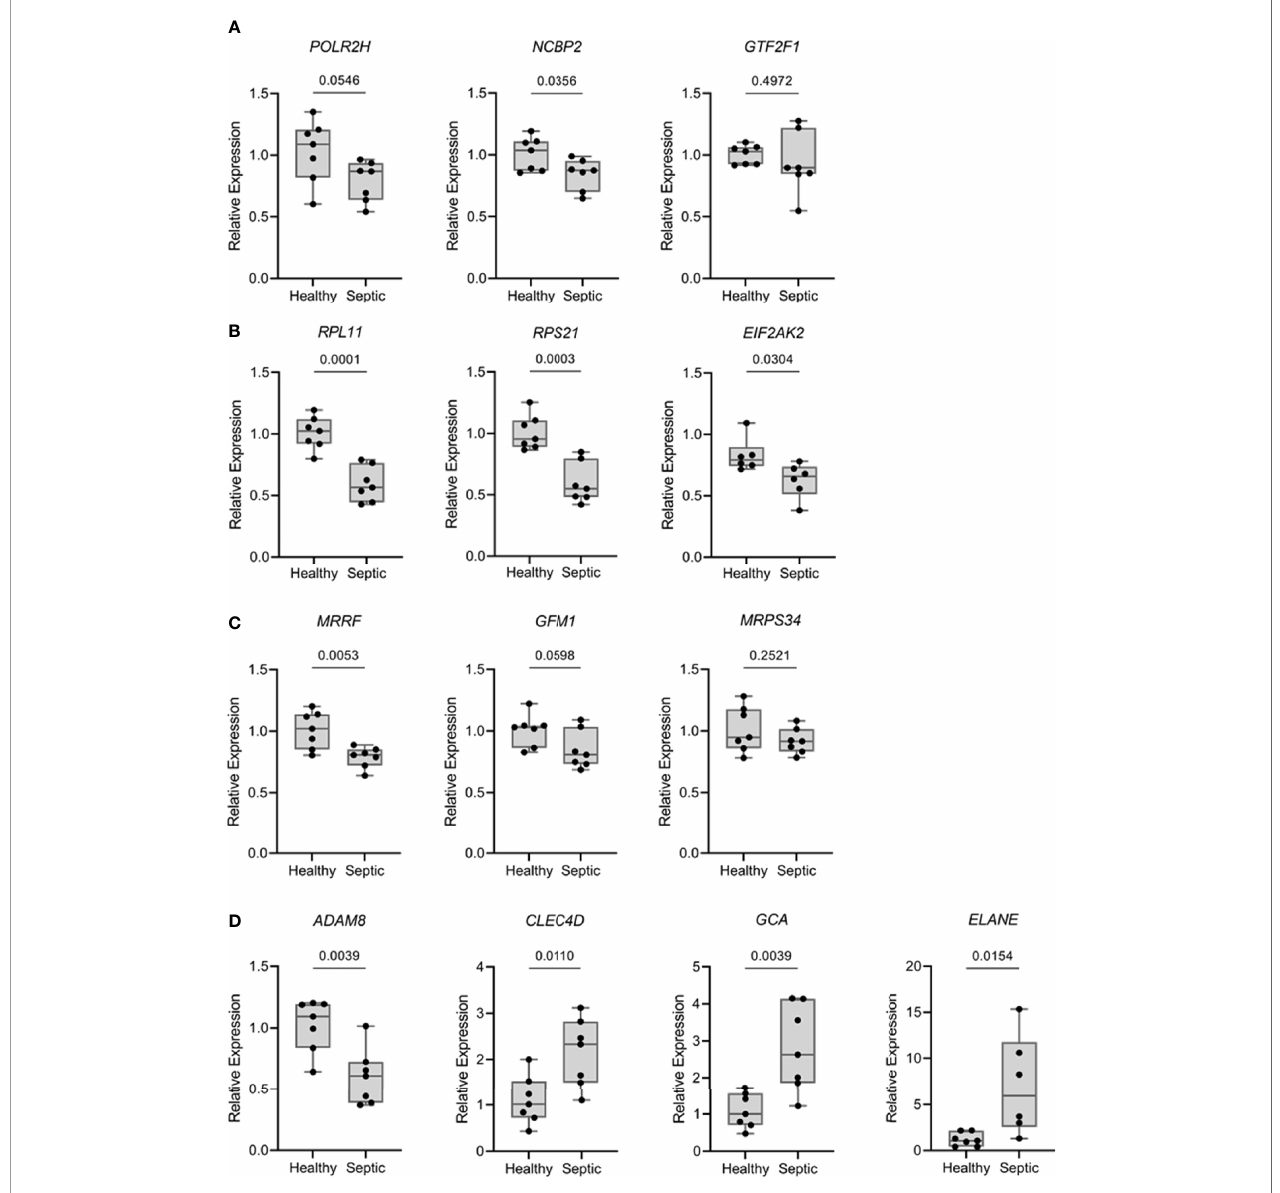
FIGURE 5 | Expression levels of relevant mRNA from over-represented pathways were analyzed by qPCR comparing septic patients ( n = 7) with healthy volunteers ( n = 7). Results are expressed as the relative gene expression (2 - ΔΔ Ct ). (A) Genes related with transcriptional processes ( POLR2H , NCBP2 and GTF2F1 ). (B) Genes related with translational processes ( RPL11 , RPS21 and EIF2AK2 ). (C) Genes related with mitochondrial translation ( MRRF , GFM1 and MRPS34 ). (D) Genes related with extravasation of leukocytes, killing of bacteria and neutrophils ( ADAM8 , CLEC4D , GCA and ELANE ). Data are presented in box plots showing all individual values. P -values were determined using student ’ s t